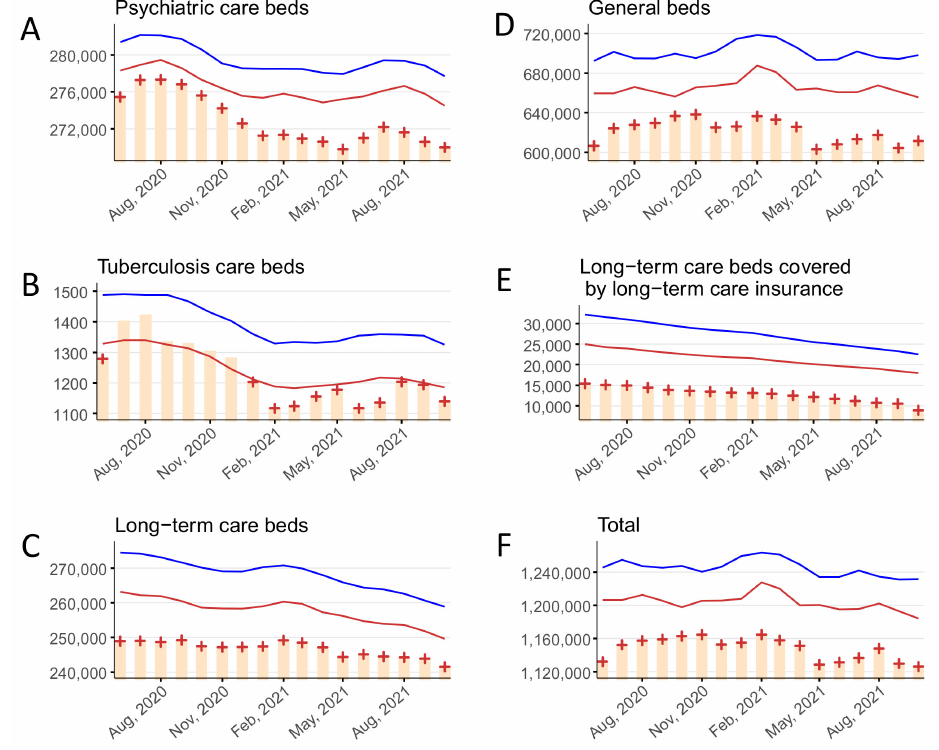
Figure 2. The monthly average number of inpatients per day stratified by bed type, June 2020– October 2021, in ( A ) psychiatric beds, ( B ) tuberculosis beds, ( C ) long-term care beds, ( D ) general beds, ( E ) long-term care beds covered by long-term care insurance, and ( F ) in total. Yellow bars indicate the observed number of inpatients per day. Blue and red lines show the upper and lower limits, respectively, of the 95% prediction interval. Red + symbols indicate statistically significant monthly deficits. Gray shading corresponds to the state of emergency declarations in